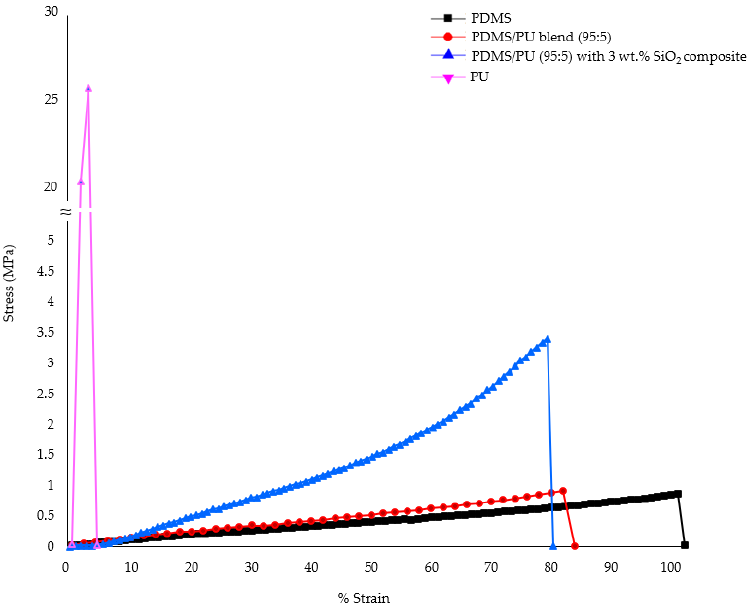
Figure 12. Stress–strain curves of neat PDMS film; PU film; PDMS/PU blend (95:5) film; PDMS/PU (95:5) with 3 wt.% SiO 2 composite film.